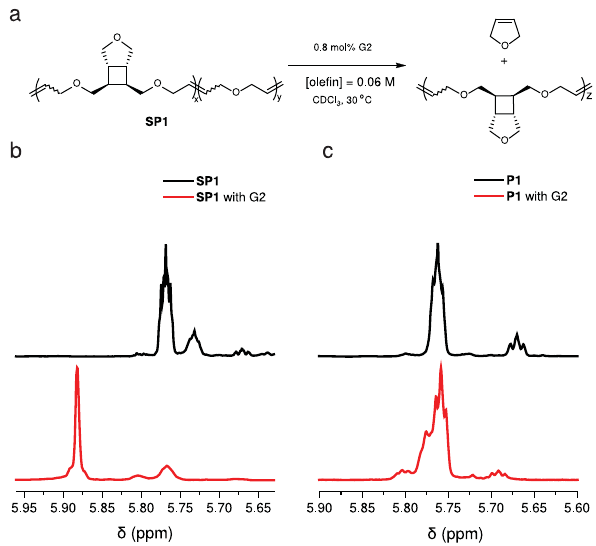
Fig. 6 | Depolymerization of SP1. a The scheme for depolymerization of SP1 . b , c Partial 1 H NMR spectra for SP1 and P1 before (black) and after (red) being stirred with G2 catalyst at 30°C for 6h.